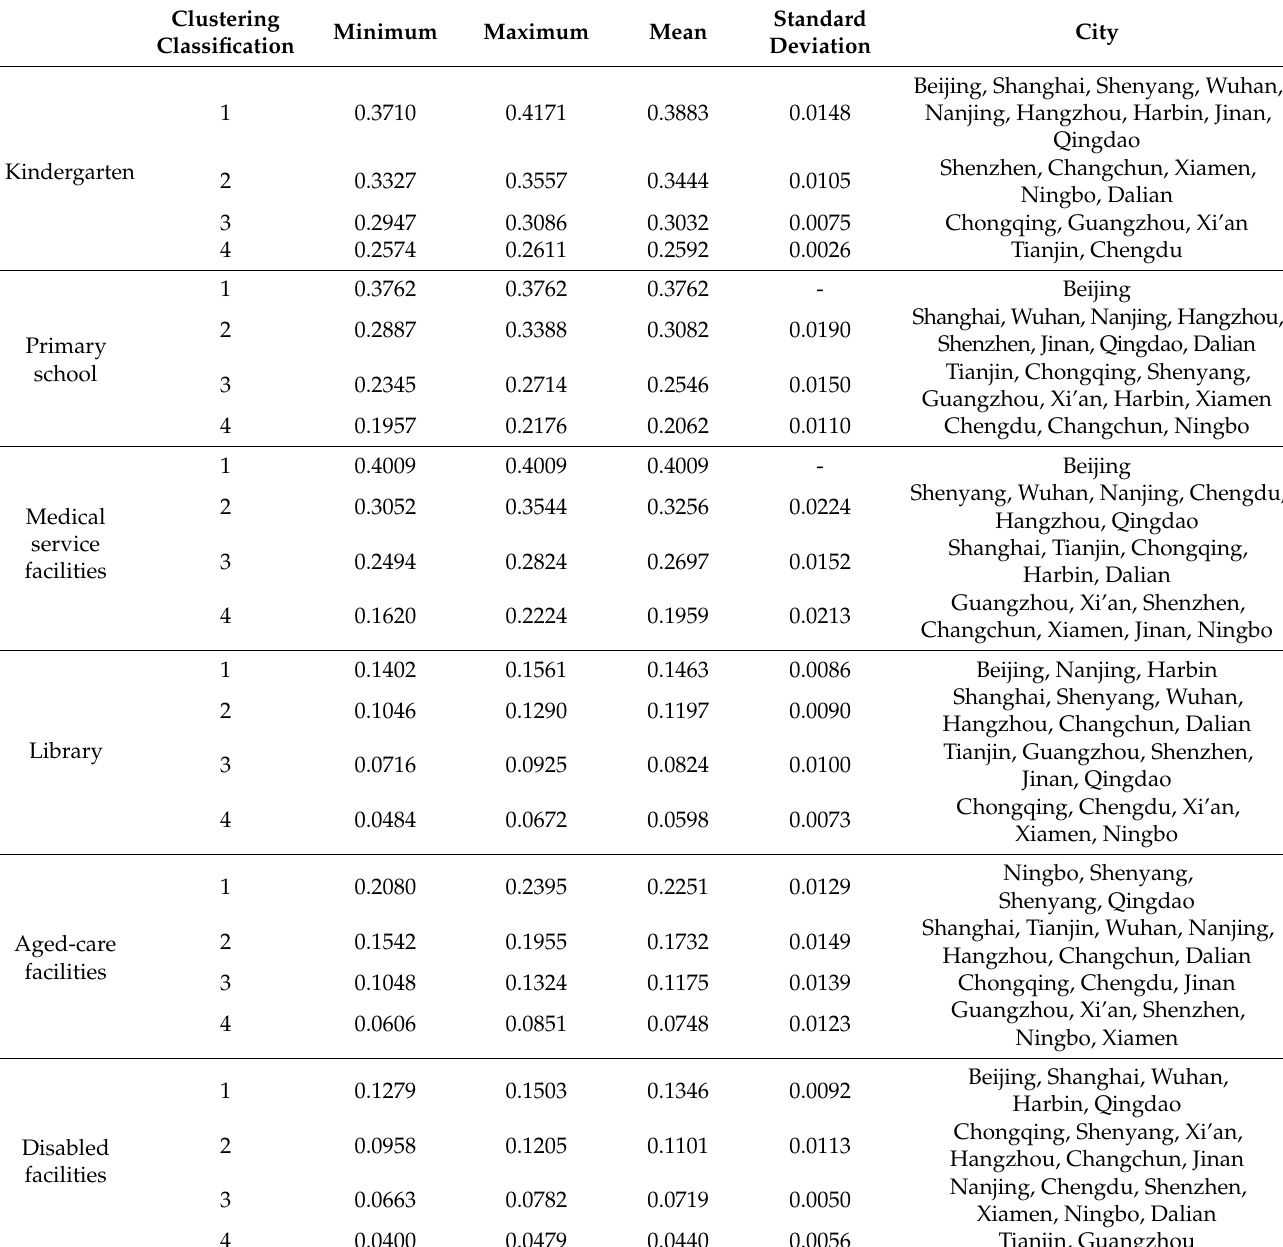
Table 4. Cluster classification results of various facilities in the